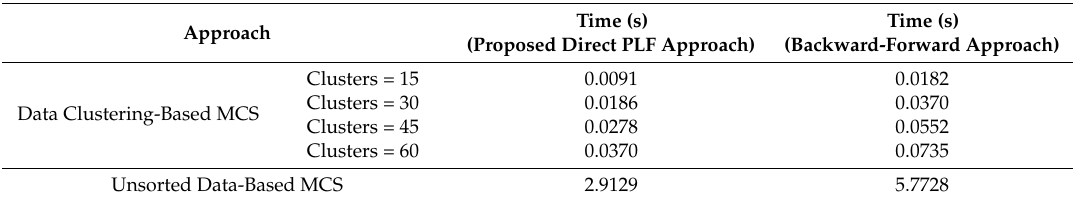
Table 3. Calculation run-time results for the proposed method, based on both simple MCS and data clustering (33-bus system).